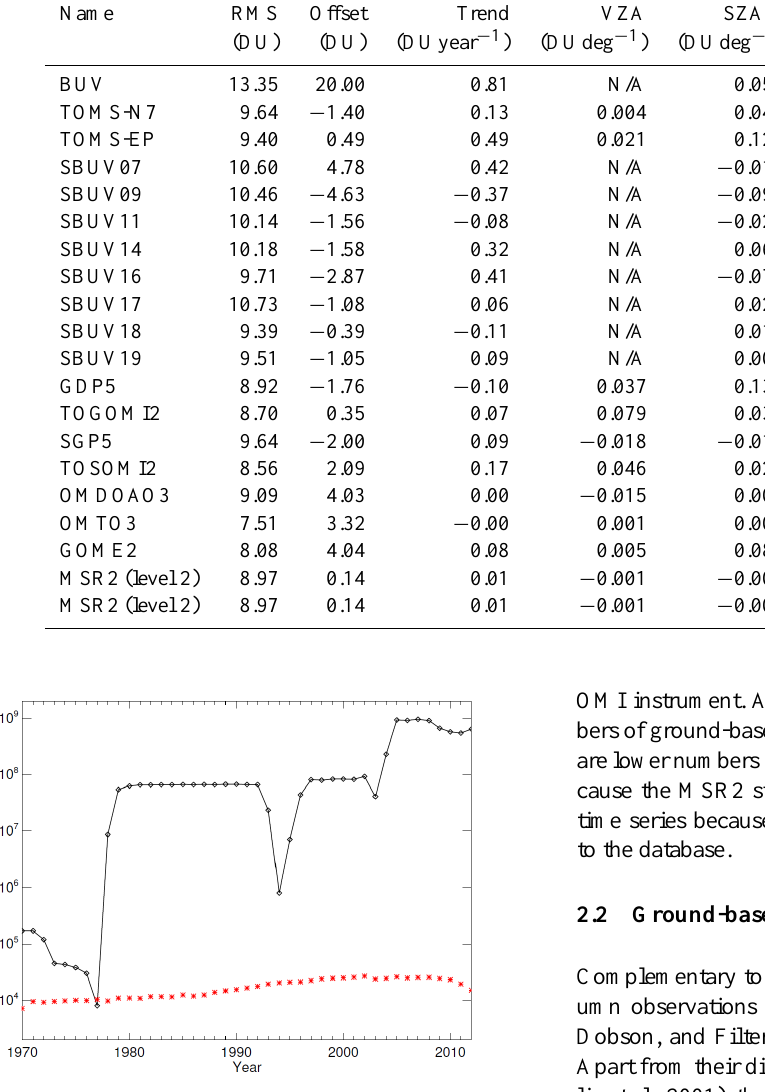
Figure 2. The number of annual satellite observations used in the compilation of the MSR2 (black line and diamonds). Note the log- arithmic scale of the y axis. The red asterisks show the number of annual ground-based observations